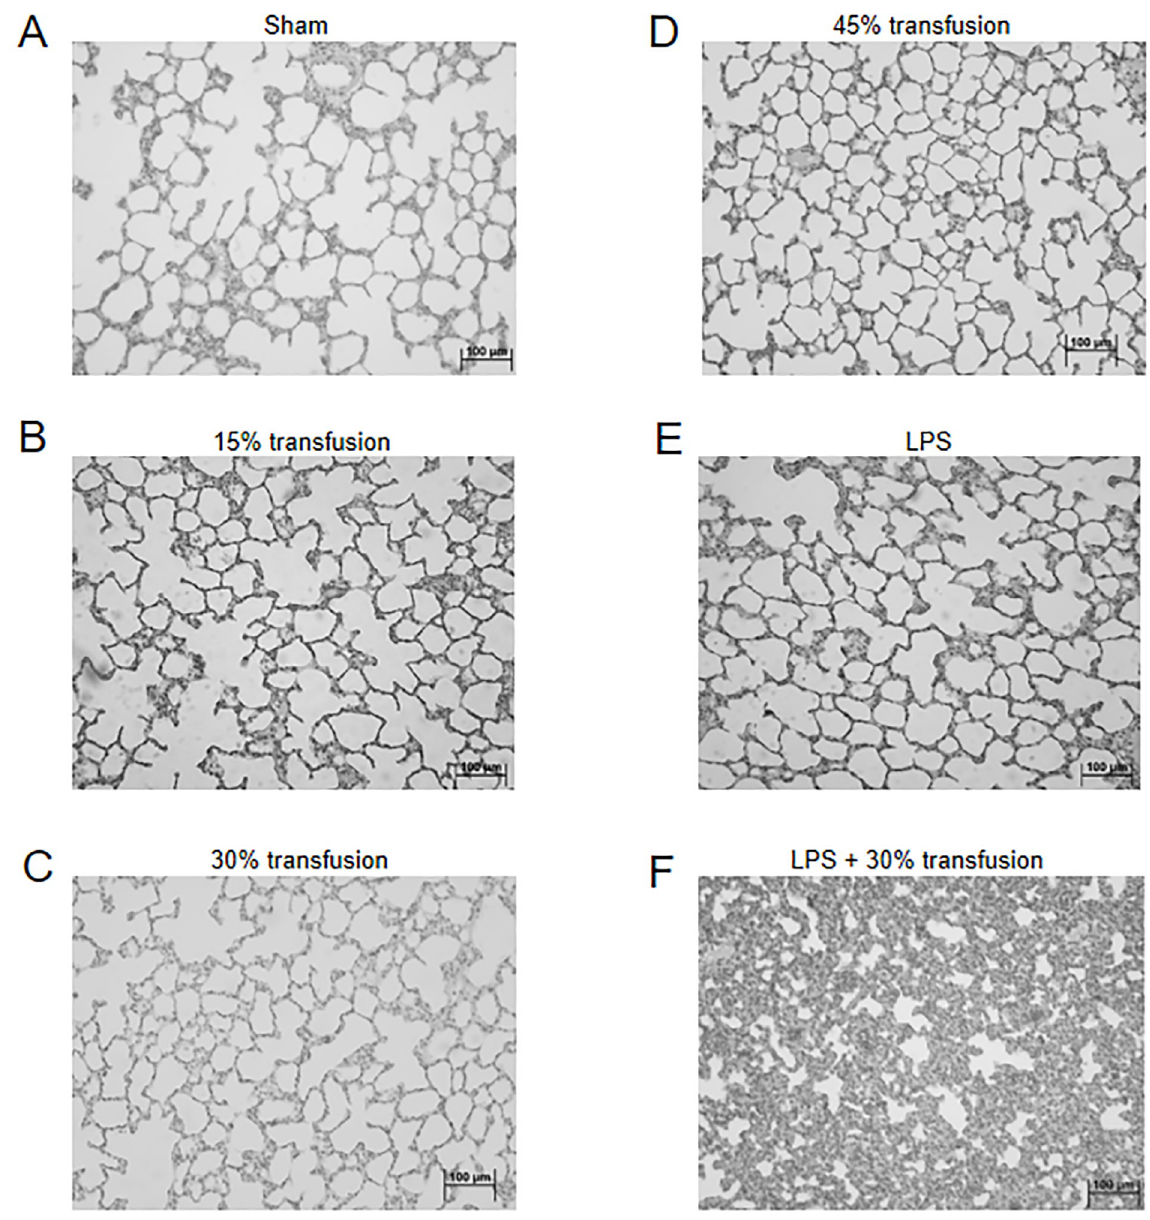
Fig 4. LPS+30% transfusion results in acute lung injury. Representative histology (H&E stain) of rat lungs. (A) Sham control. (B) 15% transfusion of human erythrocytes. (C) 30% transfusion. (D) 45% transfusion. (E) LPS only. (F) LPS+30% transfusion. Animals receiving transfusion in the absence of LPS and LPS alone demonstrated normal lung architecture as seen in sham treated animals whereas animals receiving LPS+30% transfusion showed severe neutrophil infiltration and thickening of the alveolar walls. Bar represents 100 μ m. Tissues were observed with a microscope (BX50, Olympus) at a magnification of 20X at room temperature. Images were acquired with a digital camera (DP70, Olympus). To evaluate the effect of erythrocyte transfusion in the absence and presence of LPS on lung tissue, lungs were isolated from a subset of the animals four hours after erythrocyte transfusion and weighed. Wet lung weight showed that animals receiving 30% erythrocyte transfusion, LPS alone or LPS+30% transfusion had a significant increase in lung weight of 34%, 36% and